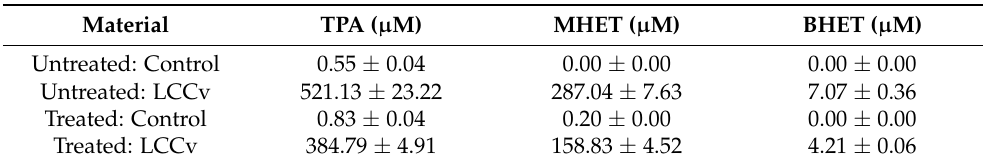
Table 5. Monomer concertation after a four-day incubation of LCCv enzyme with the untreated and treated PET